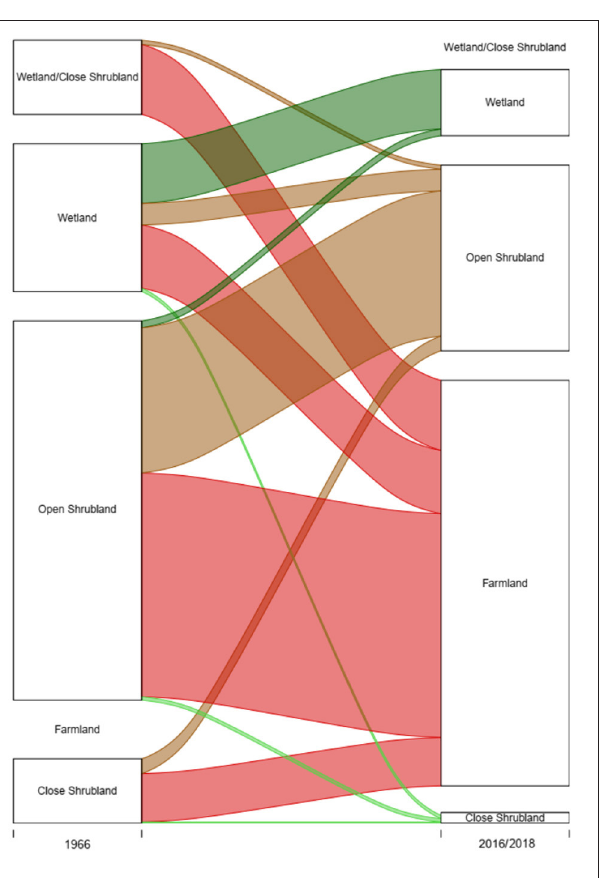
FIGURE 4 | Alluvial diagram showing changes in land use/cover between 1966 and